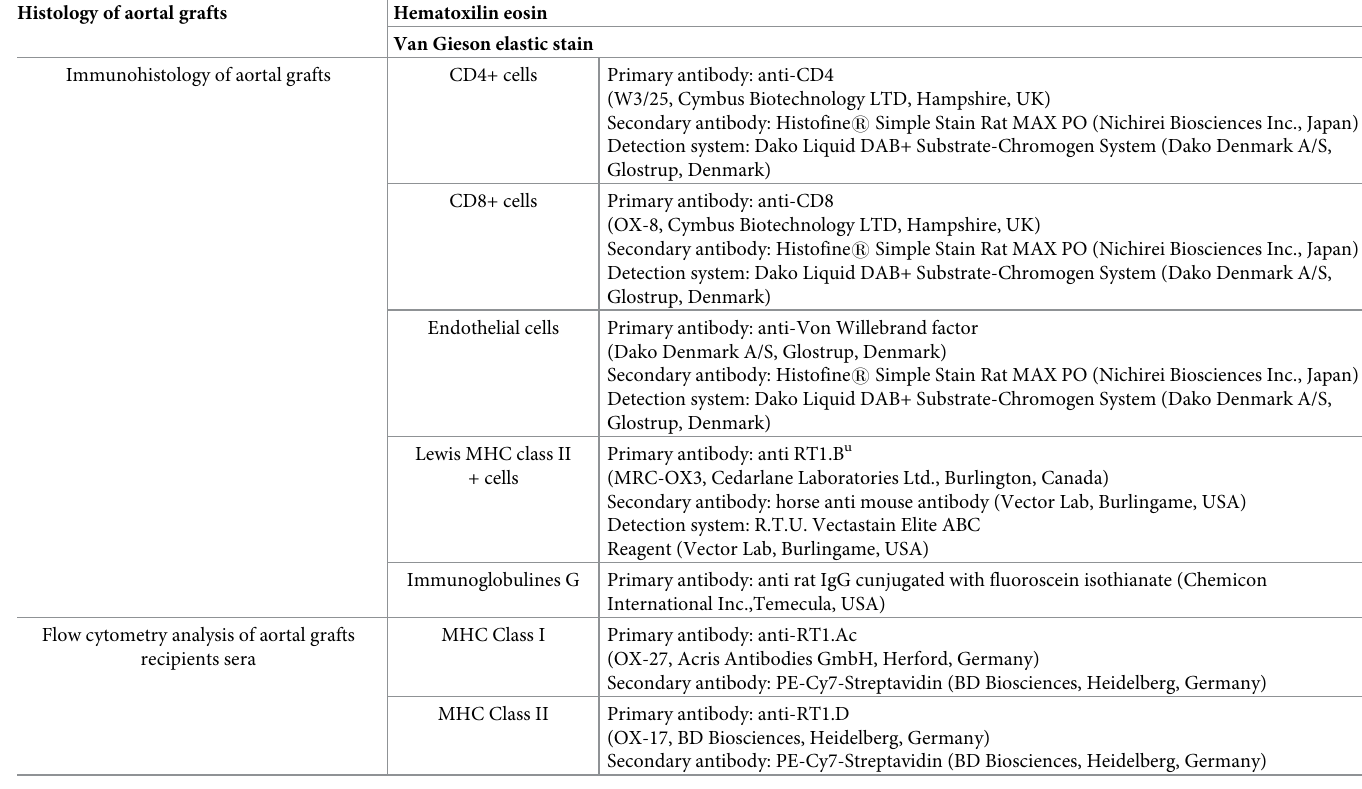
Table 2. Detailed specifications of antibodies and immunohistological techniques